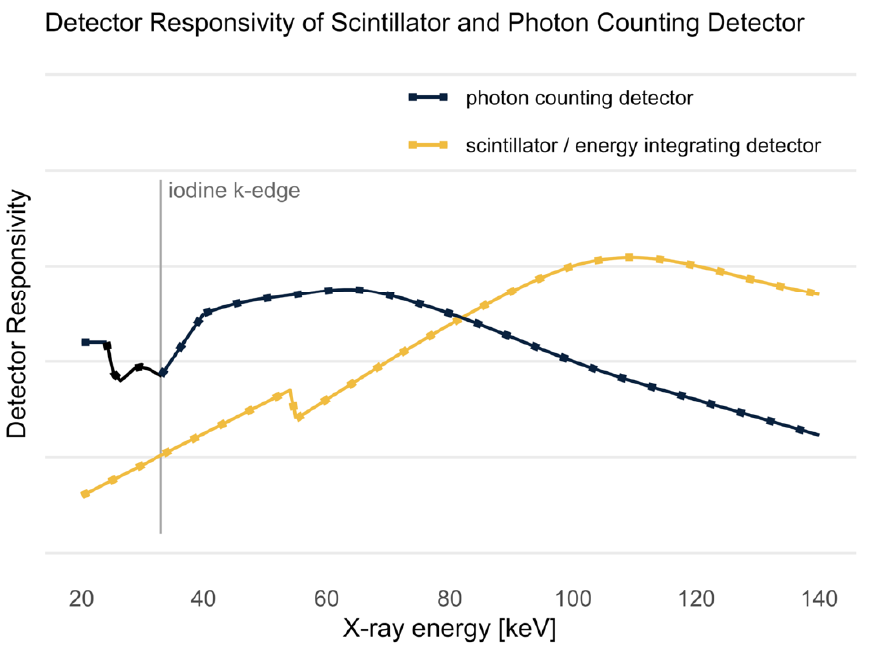
Figure 8. Detector responsivity of scintillator (energy integrating detector) and photon counting detector as a function of the X-ray energy in the X-ray spectrum. The k-edge of iodine is plotted as a vertical line at 33 keV. Figure adapted from Flohr et al. [15] .